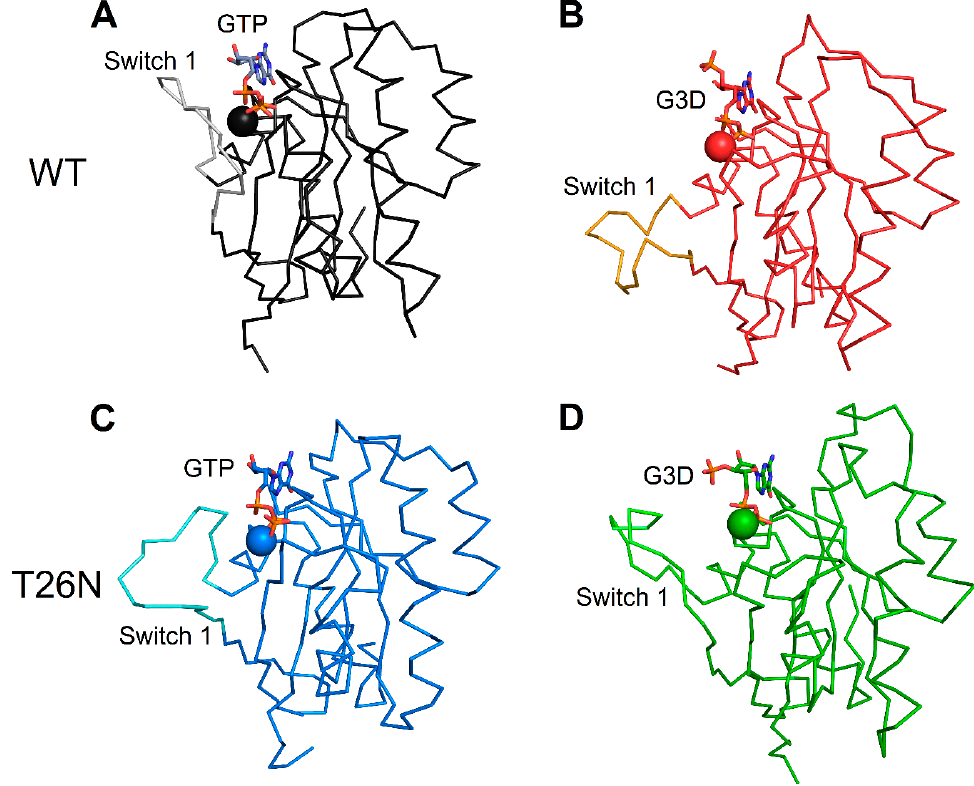
structure, GTP/G3D are represented as sticks with N atoms in blue, O atoms in red, and P atoms in orange and labeled. The switch 1 region of each state is highlighted with a lighter hue of the protein structure color and labeled.